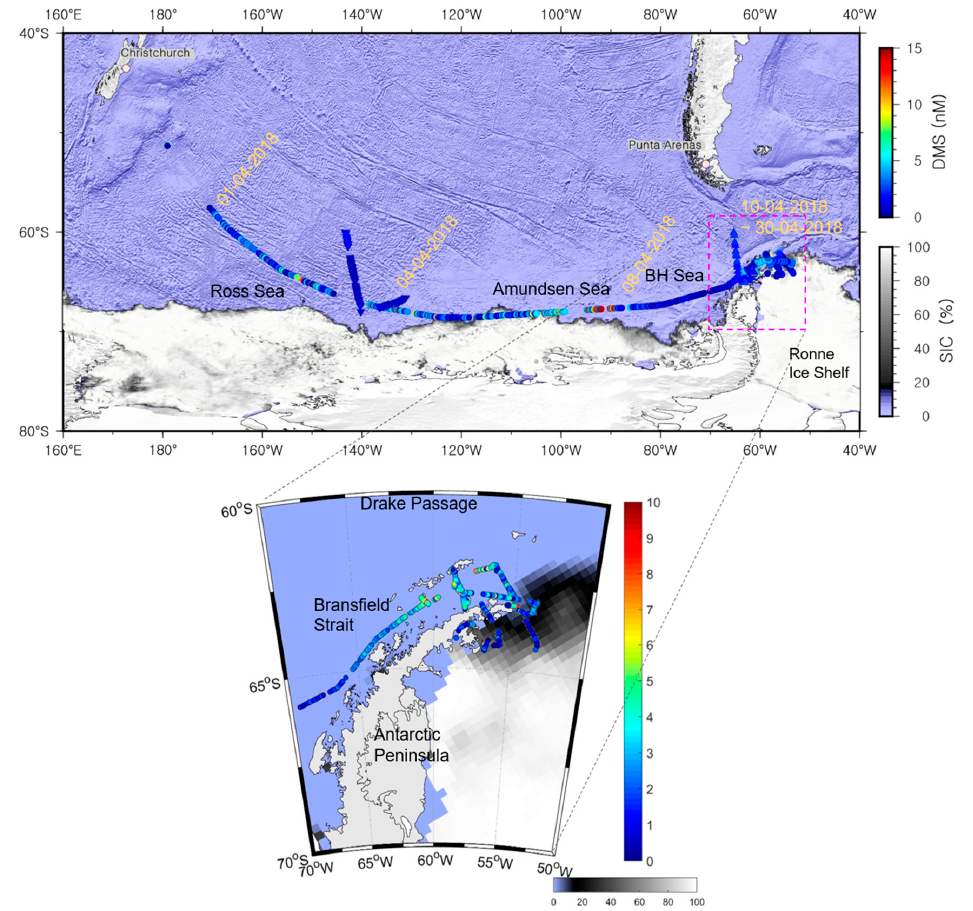
Figure 1. Map of the study area and DMS concentrations (circles) with sea ice concentration (SIC) following the cruise track in the Pacific sector of the Southern Ocean (upper figure), with the map expanded to the Antarctic Peninsula coastal region (lower figure). Triangles and inverted triangles denote the previous DMS data reported by Berresheim [18] and Berresheim et al. [19], respectively.